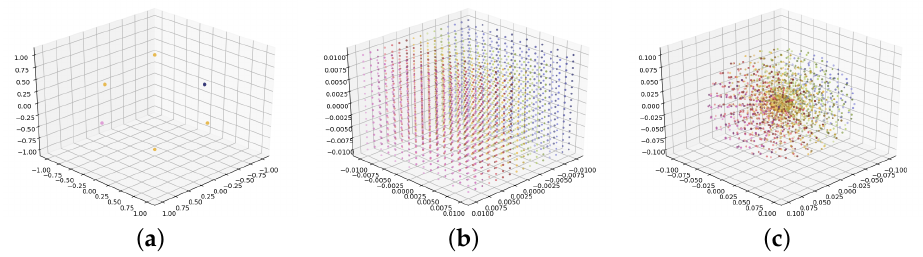
Figure 5. Three examples of handcrafted base poses. ( a ) Orthonormal vectors ( n = 6); ( b ) Uniform sampling in the cube ( n = 2048); ( c ) Uniform sampling in the sphere ( n = 2048). Symbol n denotes the number of handcrafted base poses. Different colors mean different handcrafted base poses.